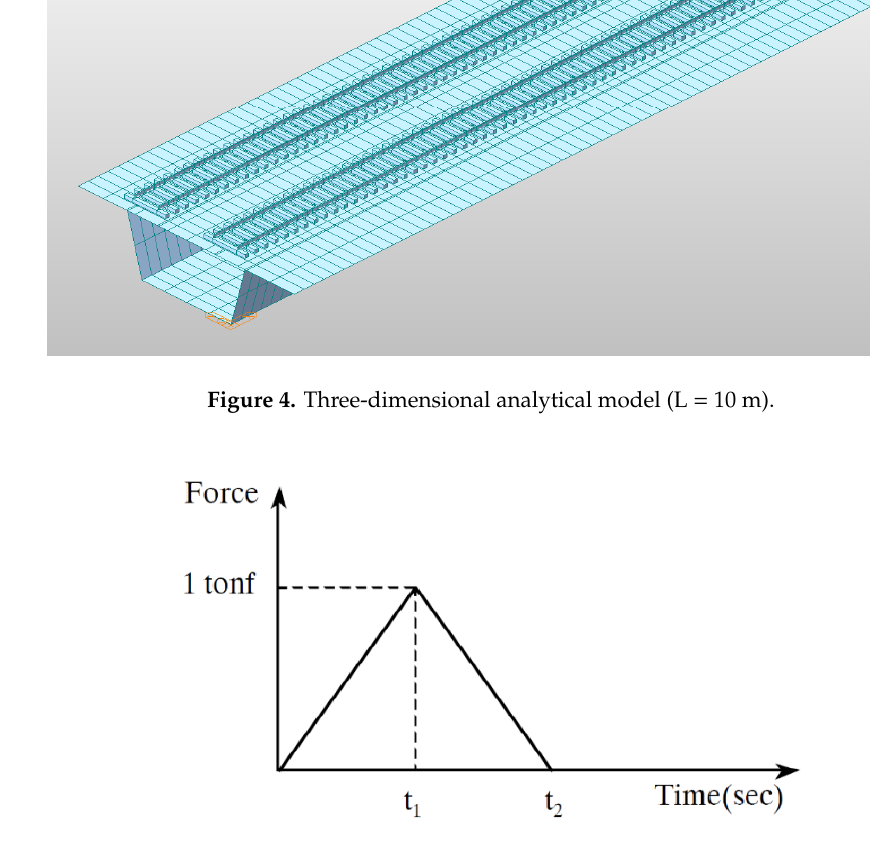
Figure 6. Time histogram function results for the finite element analysis (kN).